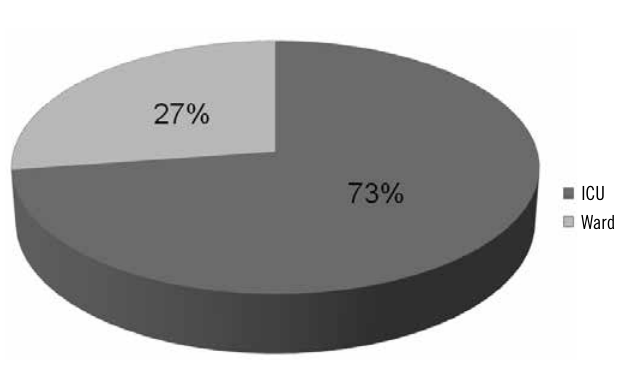
figurE 4 − Relationship between positive blood culture due to the presence of ESBL and the location of patient inside the hospital ESBL: Extended-spectrum beta-lactamases; ICU: Intensive Care